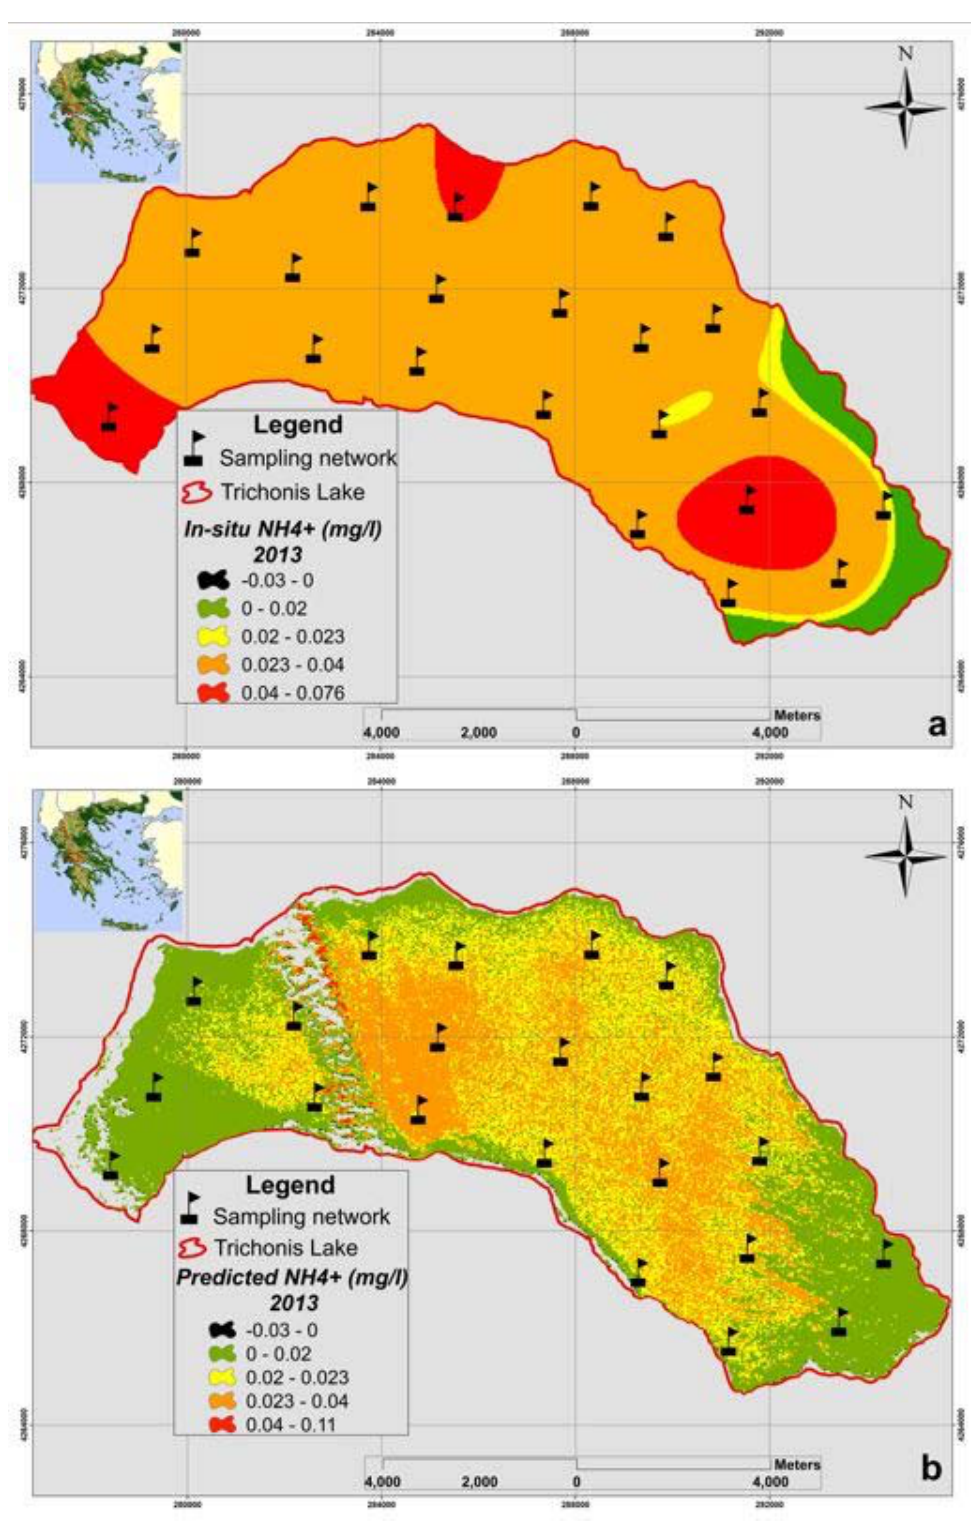
Figure 6. ( a ) In ‐ situ NH 4+ (mg/L) spatial distribution of 2013 and ( b ) Satellite derived NH 4+ (mg/L) of 2013 along the Trichonis Lake, after applying the satellite ‐ predictive algorithm.